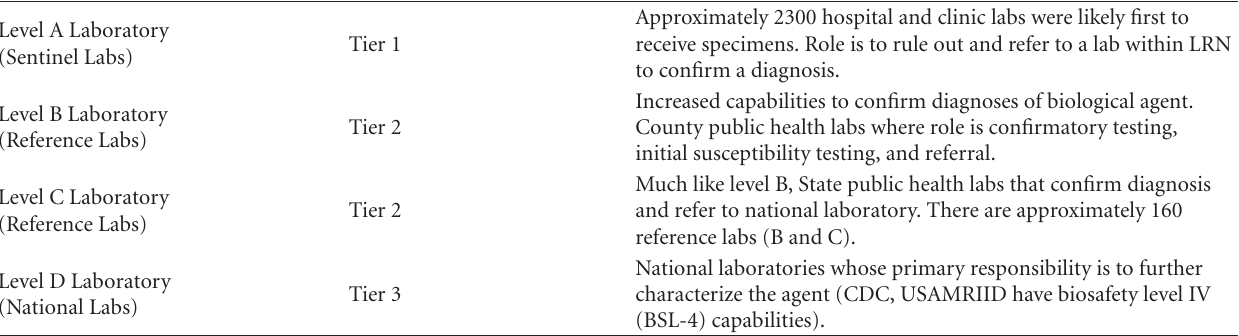
Table 2: Laboratory divisions within the laboratory response